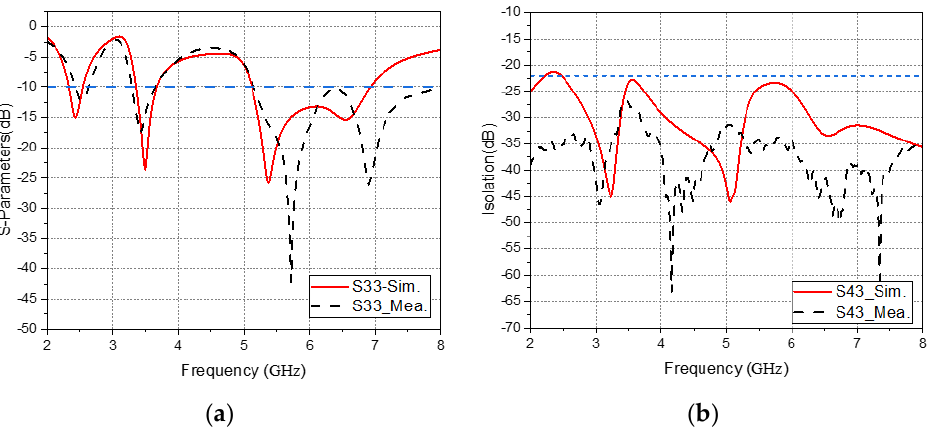
Figure 16. ( a ) Simulation and measurement of the reflection coefficient |S33| of Ant. 3, and ( b ) simulation and measurement of the isolation of Ant. 3 and Ant. 4.